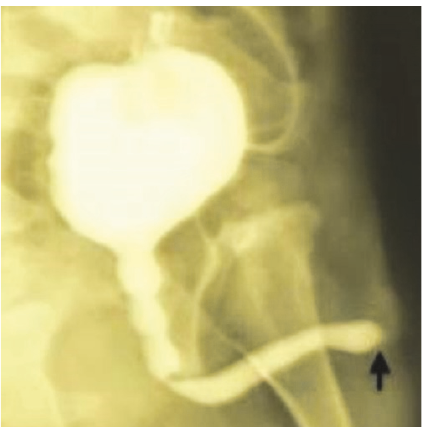
Figure 1: Antegrade VCUG via the suprapubic catheter after surgery for bladder rupture; full-length urethral dilation is evident up to point of obstruction (black arrow).